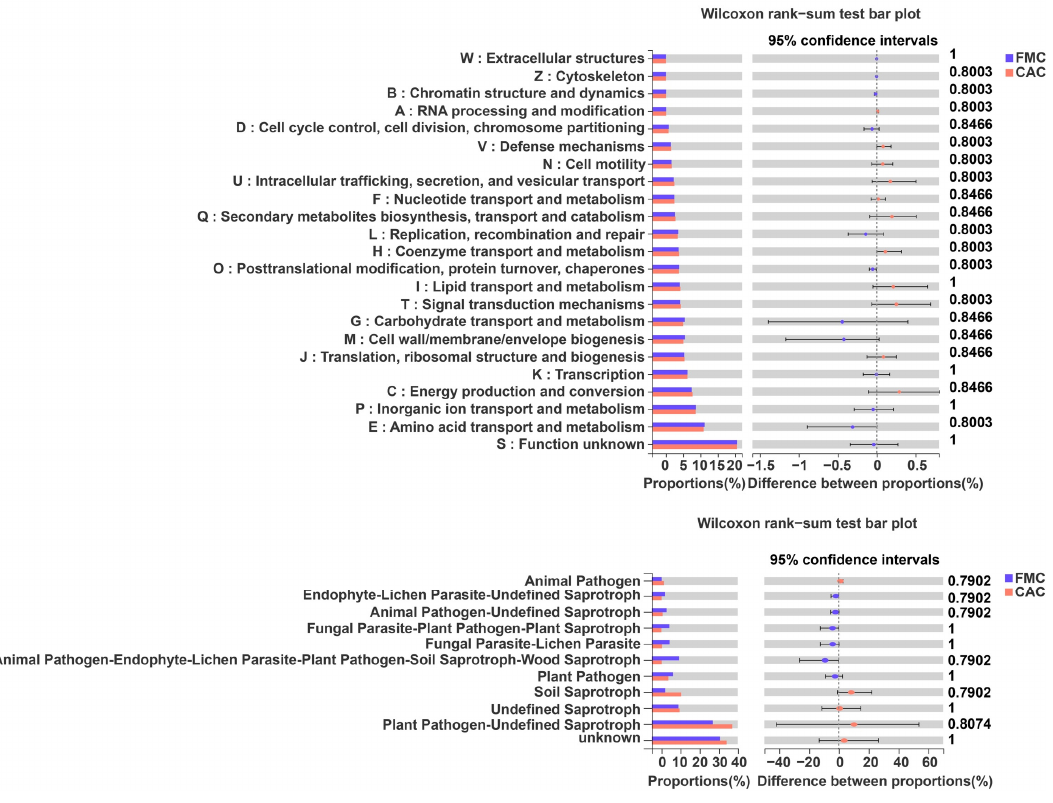
Figure 7. Functional predictions of the bacterial ( a ) and fungal ( b ) communities in stems of sugar- canes under FMC and CAC treatments. FMC—fully mechanized cultivation; CAC—conventional artificial cultivation.